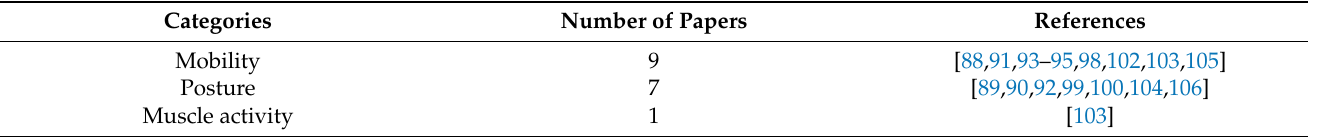
Figure 2. Flow chart of the paper selection for physical parameter monitoring. Table 3. Selected paper distribution based on the physical